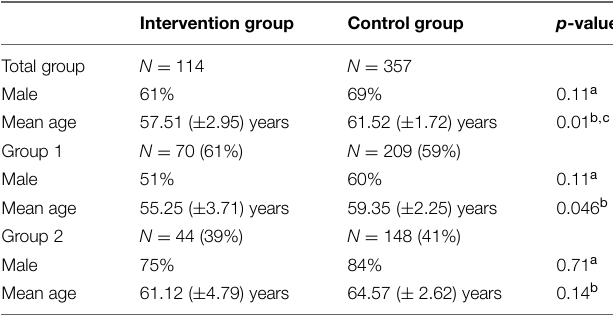
TABLE 1 | Patient baseline